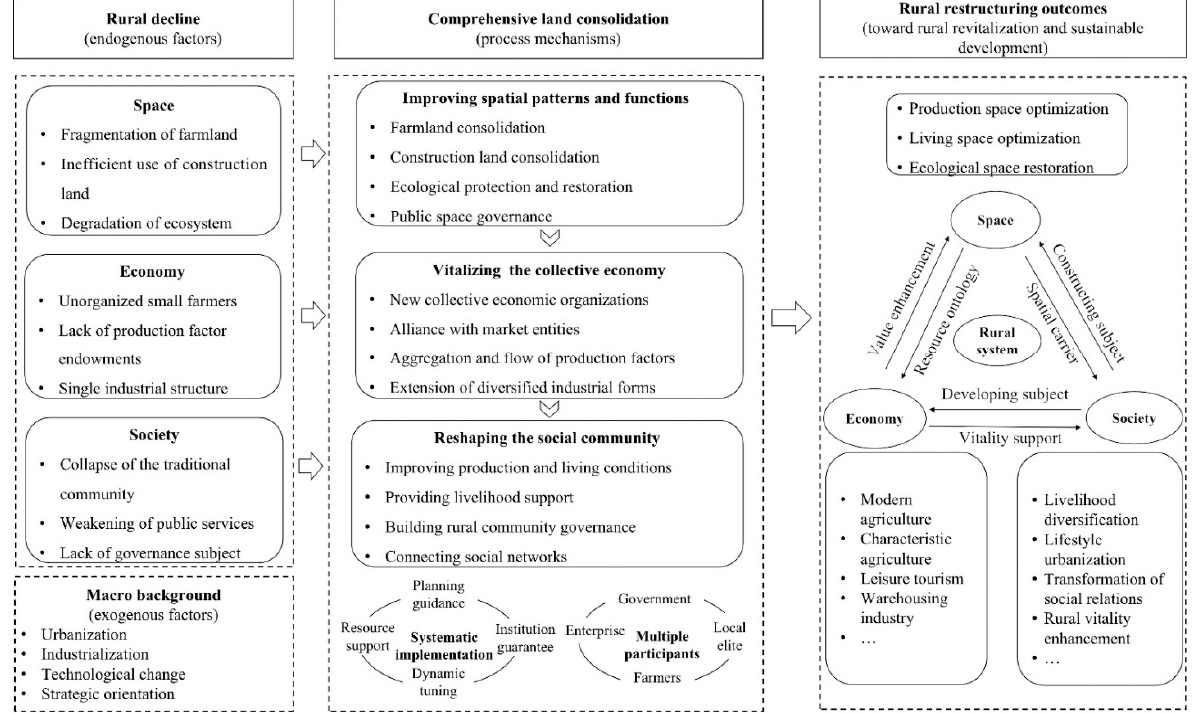
Figure 1. Theoretical framework of rural restructuring driven by comprehensive land consolidation.